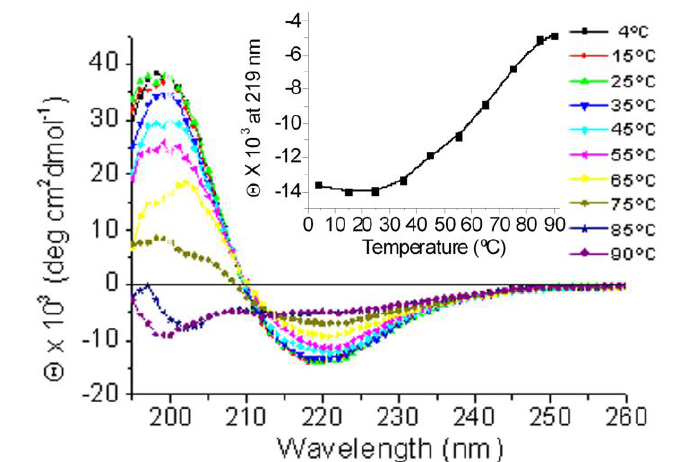
Figure 3. Temperature-induced unfolding of helix- Z . CD spectra were obtained from 4 to 90 °C. Inset shows ellipticity values at 219 nm (β-structure signal). The concentration of helix- Z employed was 200